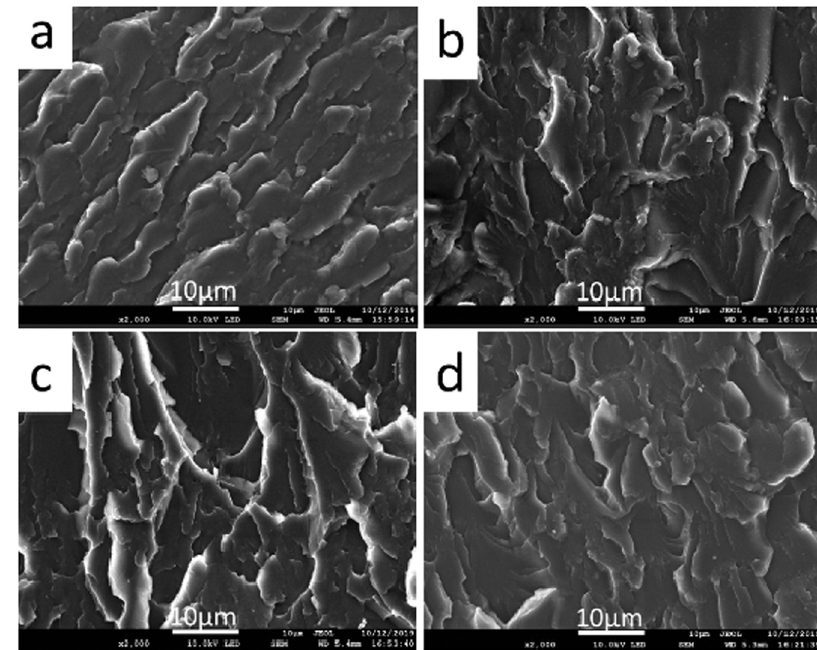
Figure A4: SEM photos of tensile section of PEF - 110 - t : ( a ) PEF, ( b ) PEF - 110 - 20, ( c ) PEF - 110 - 40, and ( d ) PEF - 110 -